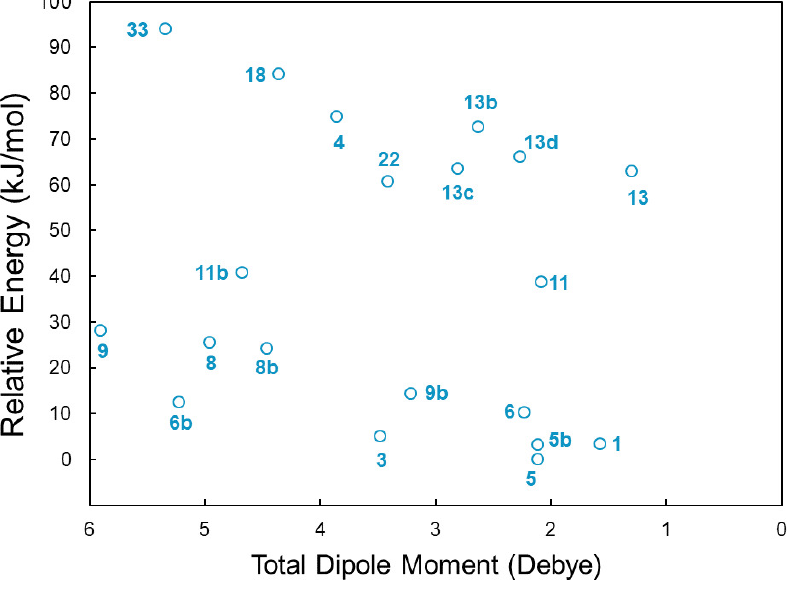
Figure 3. Total electric dipole moment (revDSD/junTZ) plotted against relative energy (CBS + CV + hZPE) for the 20 most stable isomers of the C 3 H 3 NO family. For labels, see Figure 2 and the